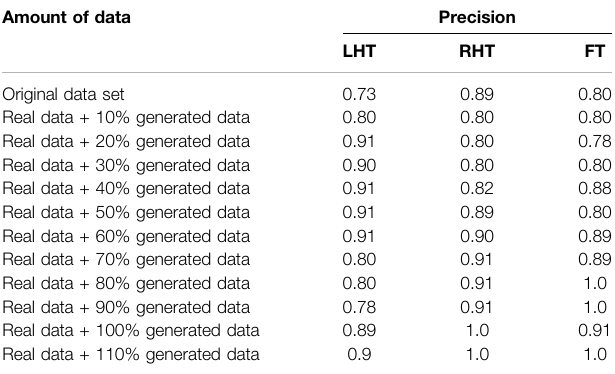
TABLE 3 | Precision for each Class in each Data set.